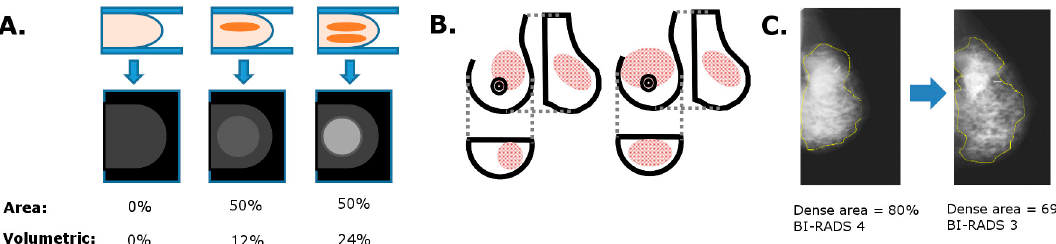
Figure 2. Limitations of area-based density measures. ( A ) Area-based density cannot accurately measure regions of overlapping tissue or increased tissue depths; ( B ) Areas of density that appear different on one view (e.g., CC (craniocaudal)) can appear similar on another view (e.g., MLO (mediolateral oblique)); ( C ) 1 cm of extra compression can alter the visually assessed density and thus BI-RADS category.